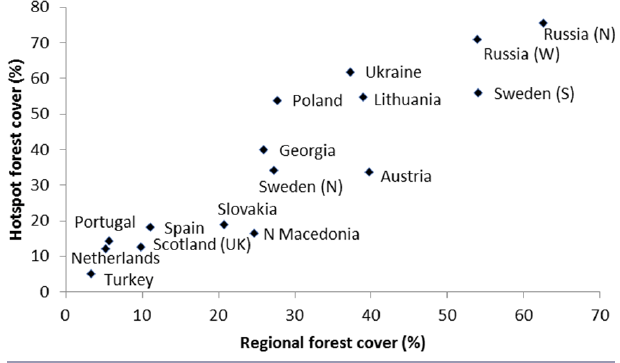
Fig. 4 . Graph showing the gradient from low to high forest covers in 16 Pan-European case study regions and constituent local “hotspot”